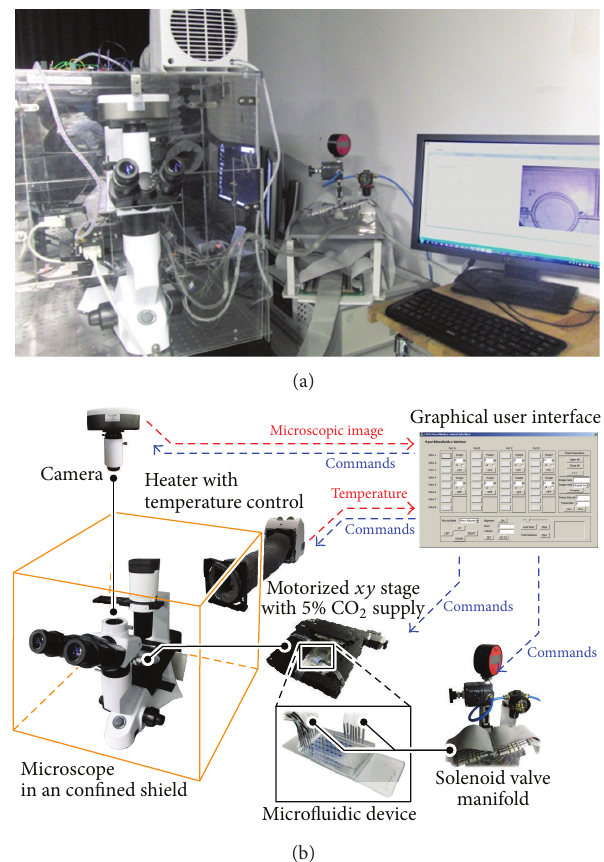
Figure 1: (a) Photograph and (b) schematics of the automated microfluidic parallel monitoring